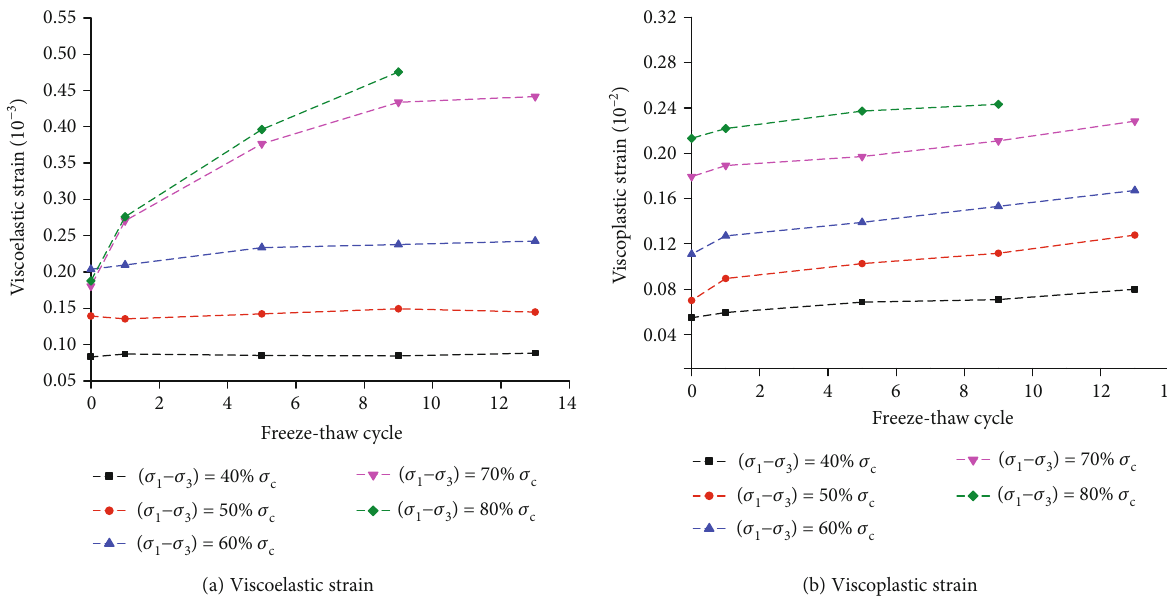
Figure 14: Curves of (a) viscoelastic strain and (b) viscoplastic strain versus the number of freeze-thaw cycles at various stress levels under 2MPa of con fi ning